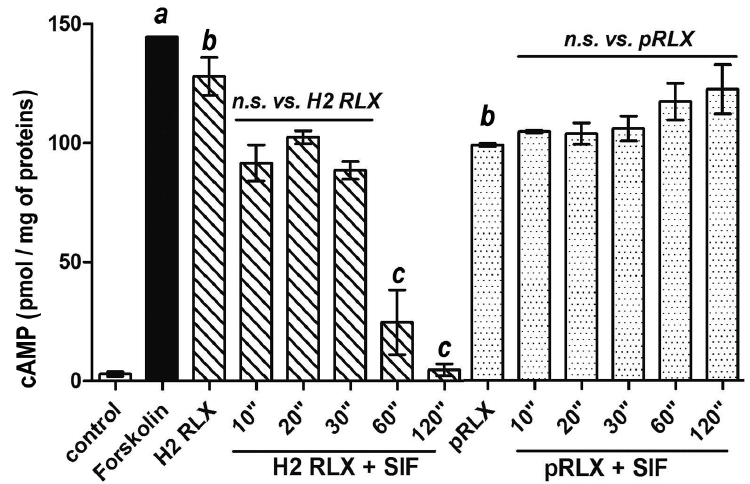
Figure 1. cAMP response by THP-1 cells upon stimulation with intact serelaxin (H2 RLX) and porcine relaxin (pRLX) (100 ng/mL) or their digestion products obtained by incubation with SIF for the reported times. Forskolin (10 −4 M) was used as positive control to evaluate the maximal cAMP levels. The H2 RLX digestion products show a progressive decrease in cAMP generation, which correlate with the SIF exposure time, whereas the pRLX digestion products stimulate the cAMP generation at similar levels as the intact peptide at all times tested (up to 2 min). Significance of differences: a,b p < 0.001 vs. control; c, p < 0.001 vs. H2 RLX; n.s., not significant.